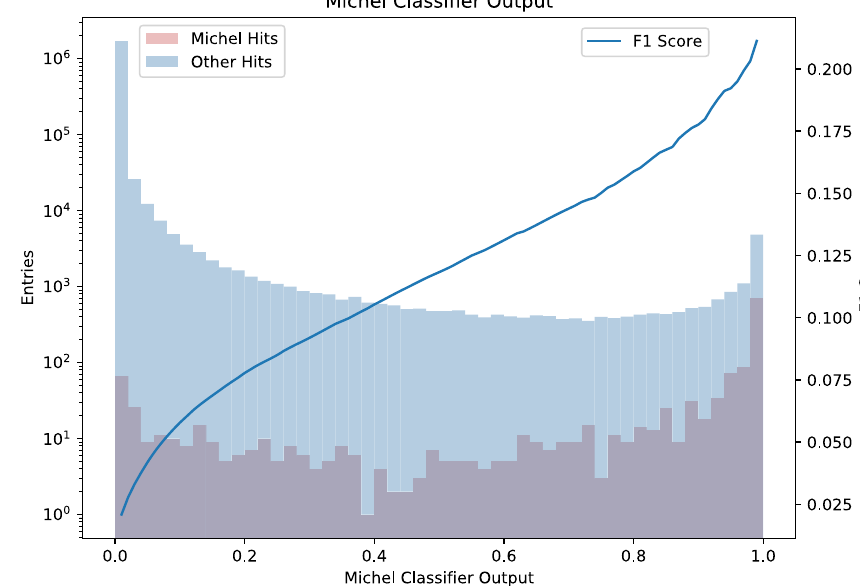
Fig. 7 Michel electron classifier output